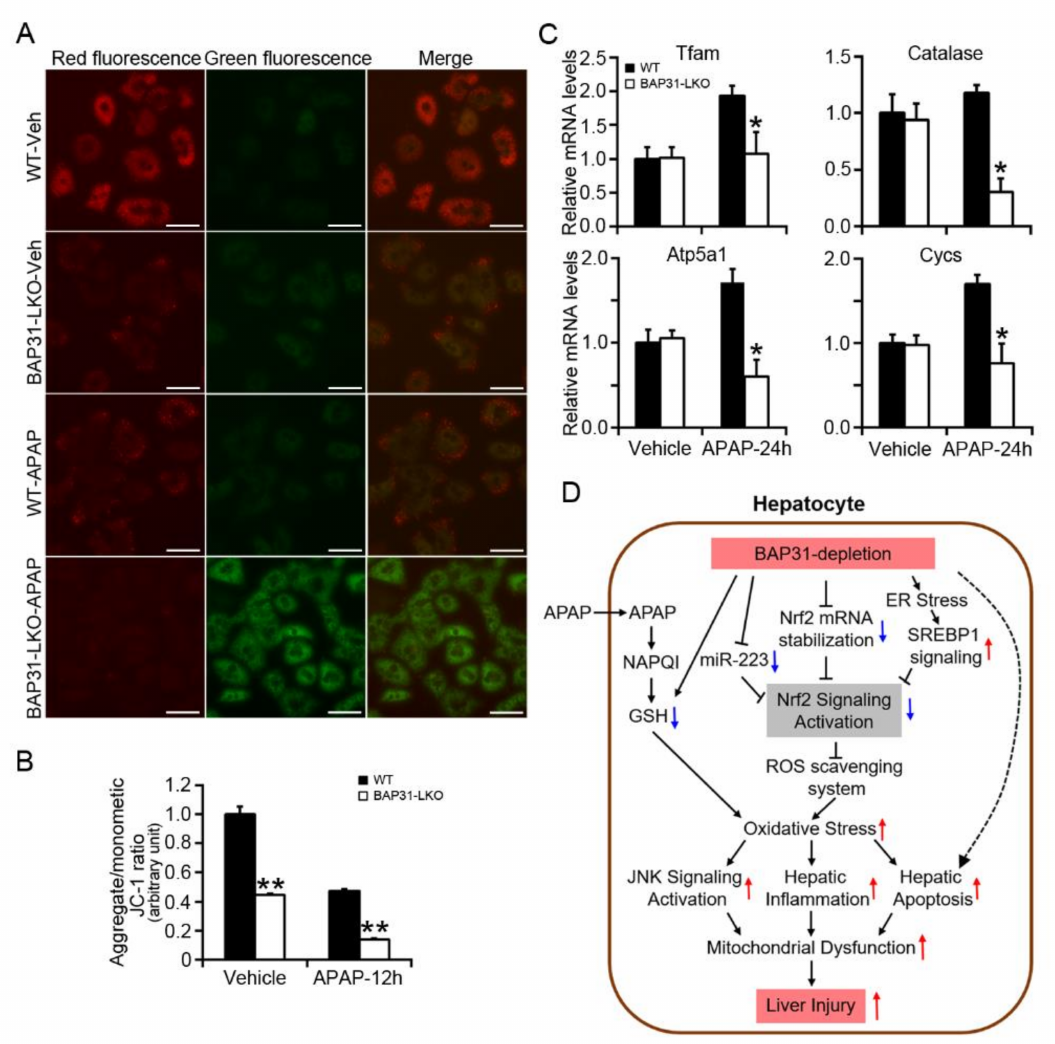
Figure 7. BAP31-deficiency increased mitochondrial dysfunction. ( A ) Representative images of JC-1 staining in primary hepatocytes treated with APAP (5 mM) for 24 h. Scar bar = 50 µ m. ( B ) Quantitative analysis of red/green fluorescence ratio in each group. All values are shown as mean ± SE from 12 independent images captured in each group. **, p < 0.01, BAP31-LKO compared to WT hepatocyte. ( C ) The mRNA levels of genes related to mitochondria function were determined in WT and BAP31-LKO mice livers upon APAP administration. n = 5 per group. Data are expressed as mean ± SE. *, p < 0.05, BAP31-LKO compared to WT mice. ( D ) The working model depicting that BAP31-depletion decreased Nrf2 mRNA stability, and Nrf2 signaling activation reduced the antioxidant response and enhanced APAP-induced oxidative stress, hepatic inflammation, and apoptosis, eventually amplified APAP-induced liver injury in